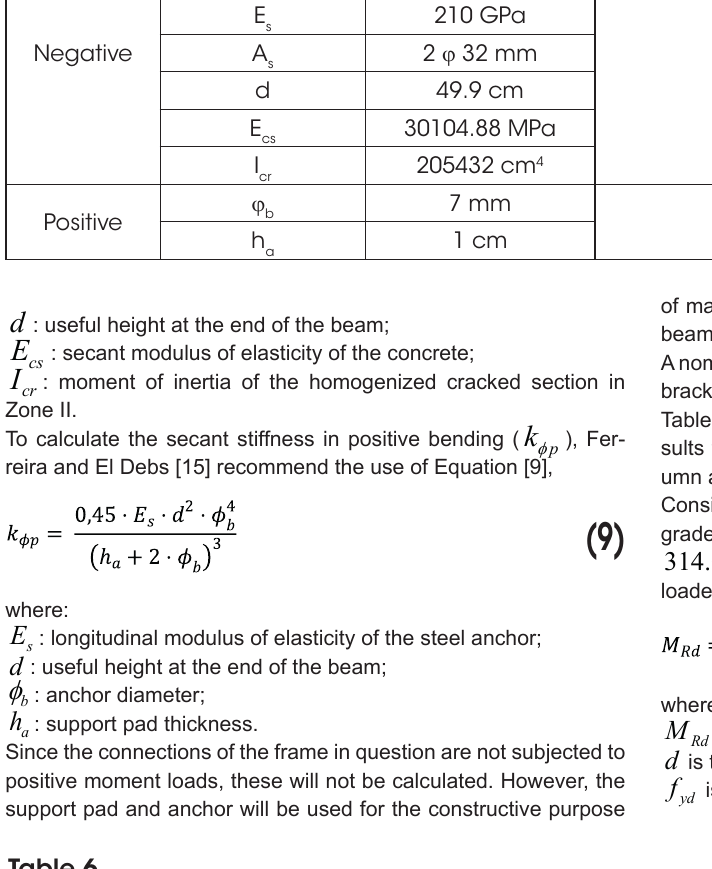
Table 6 Connection for the edge